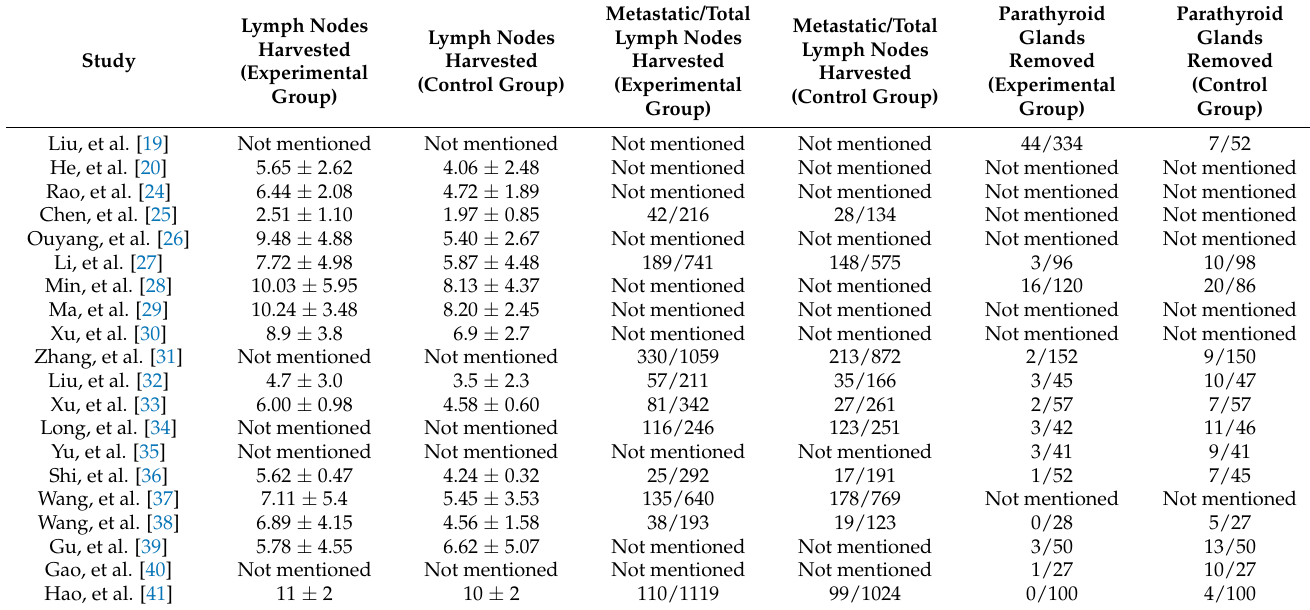
Table 2. Primary outcomes of each study included in the meta-analysis.